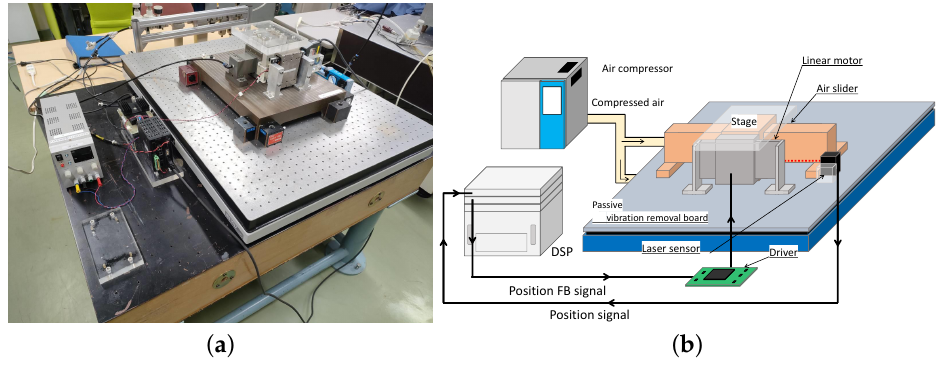
Figure 4. Experimental system. ( a ) Picture, ( b ) Schematic.